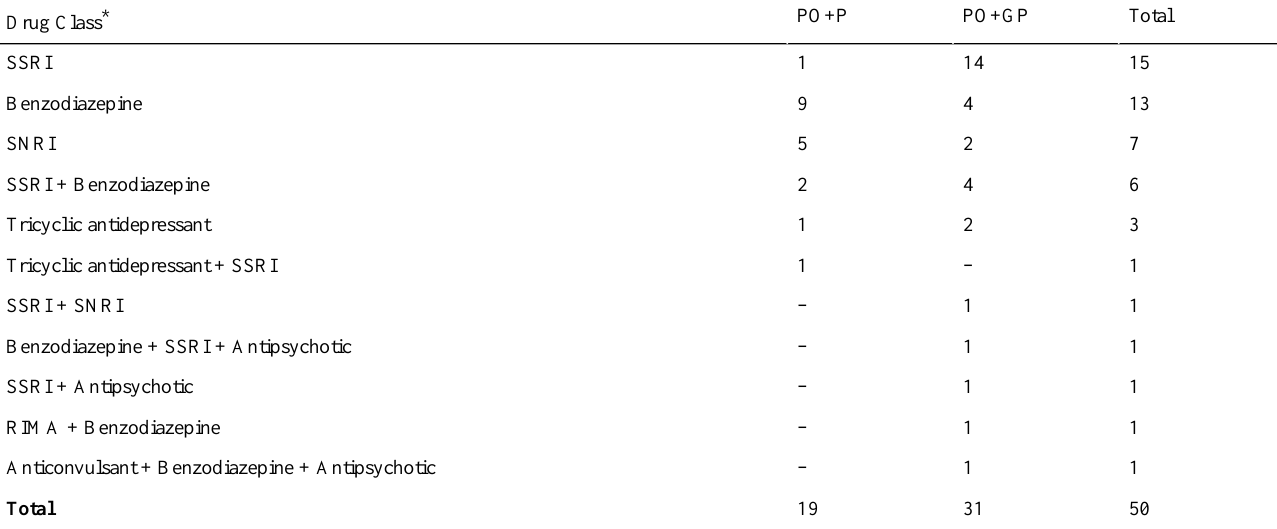
Table 2. Medication frequencies at pretreatment assessment, by